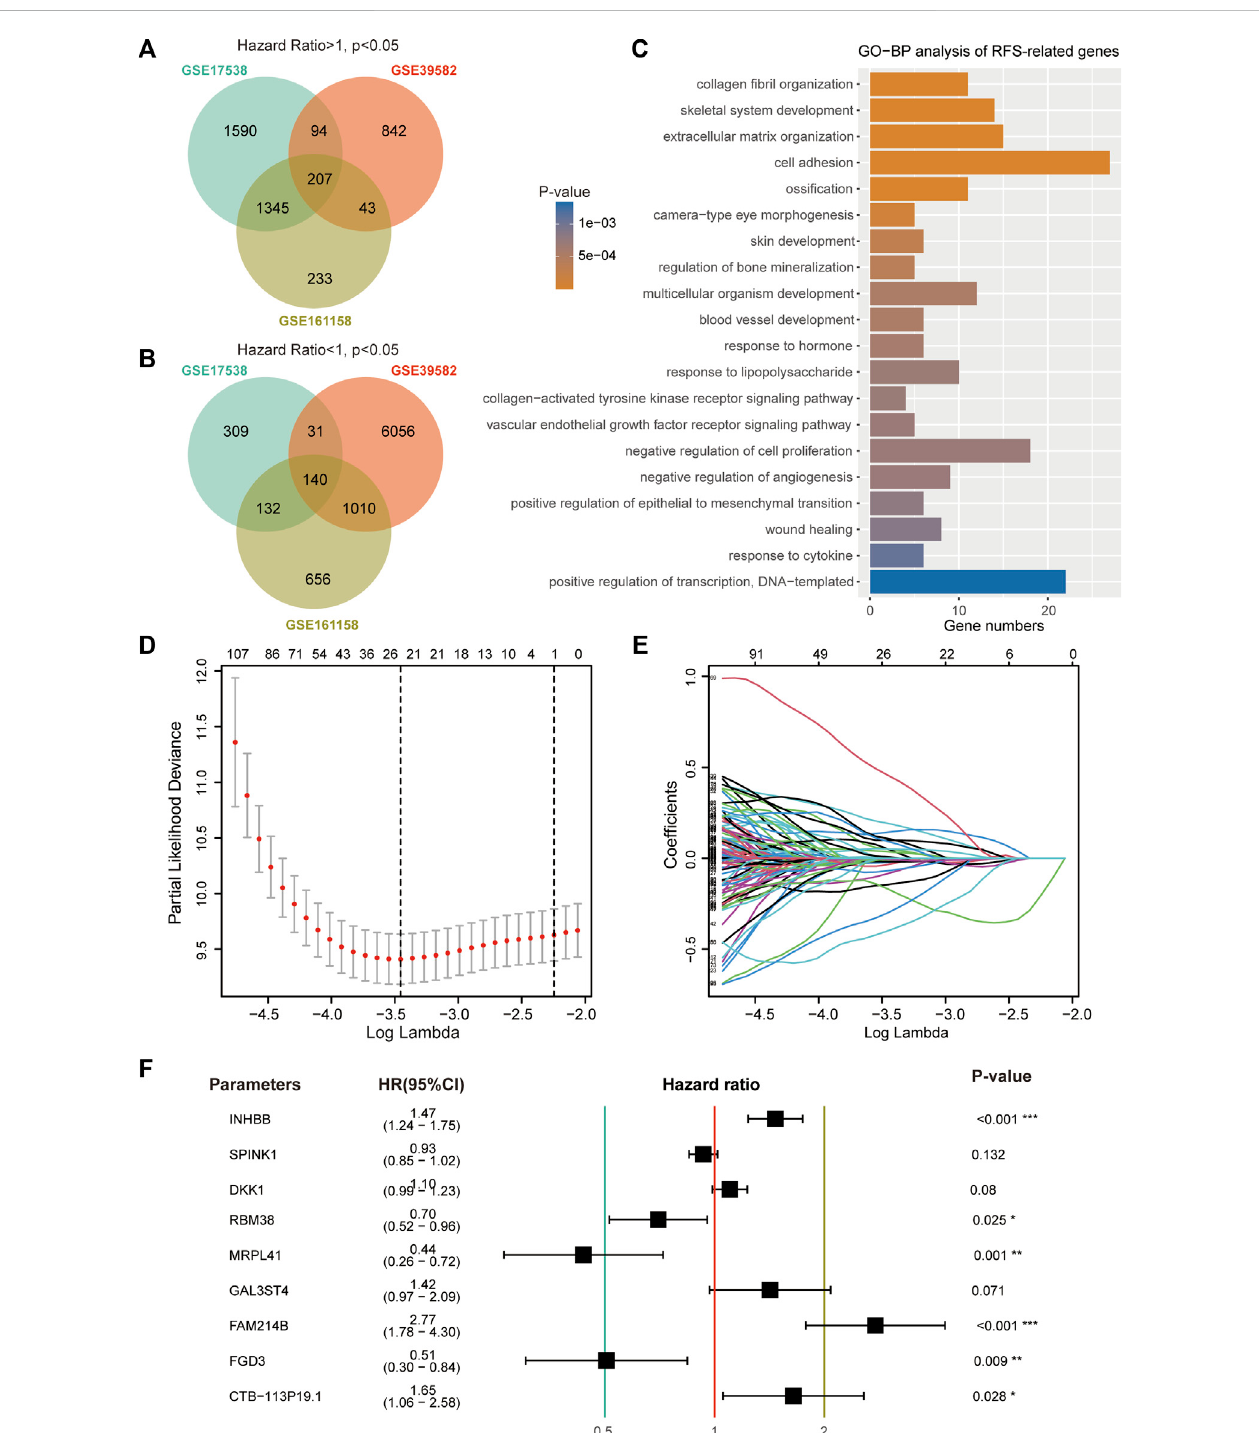
FIGURE 1 Construction of prognostic signature using RFS-related genes. (A) Venn diagram screened 207 prognostic genes with a hazard ratio > 1 in three CRC cohorts. (B) Venn diagram screened 140 prognostic genes with a hazard ratio < 1. (C) Top 20 enriched GO-BP terms of 347 RFS-related genes. (D) Cross- validation for tuning parameter (lambda) screening in the LASSO regression model. (E) LASSO coef fi cients of 24 RFS-related genes. (F) Hazard ratio, 95% CI, and p -value of the nine